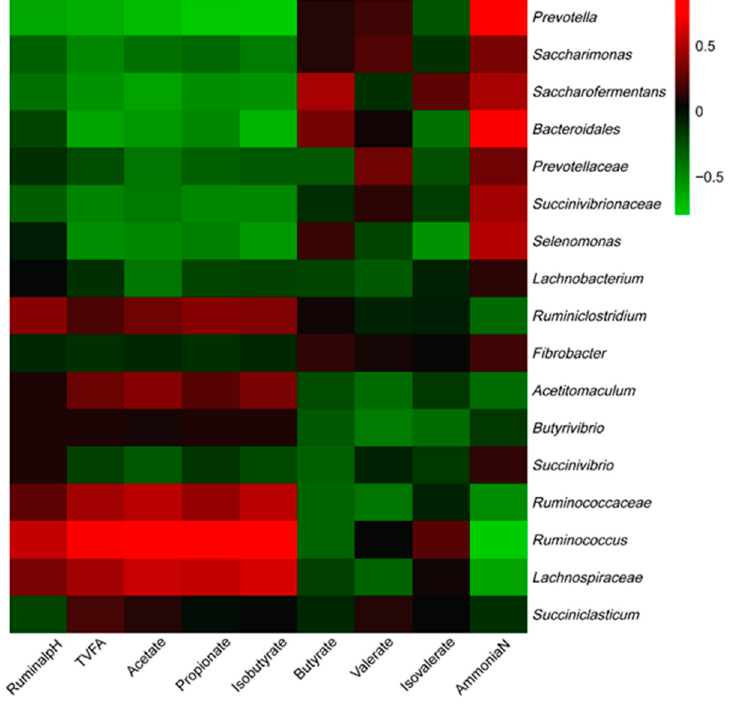
Figure 4. Correlation analyses between the most abundant genera of ruminal bacteria and DMI, milk quality parameters, and ruminal fermentation parameters. The red color represents a positive correlation while the green color represents a negative correlation.